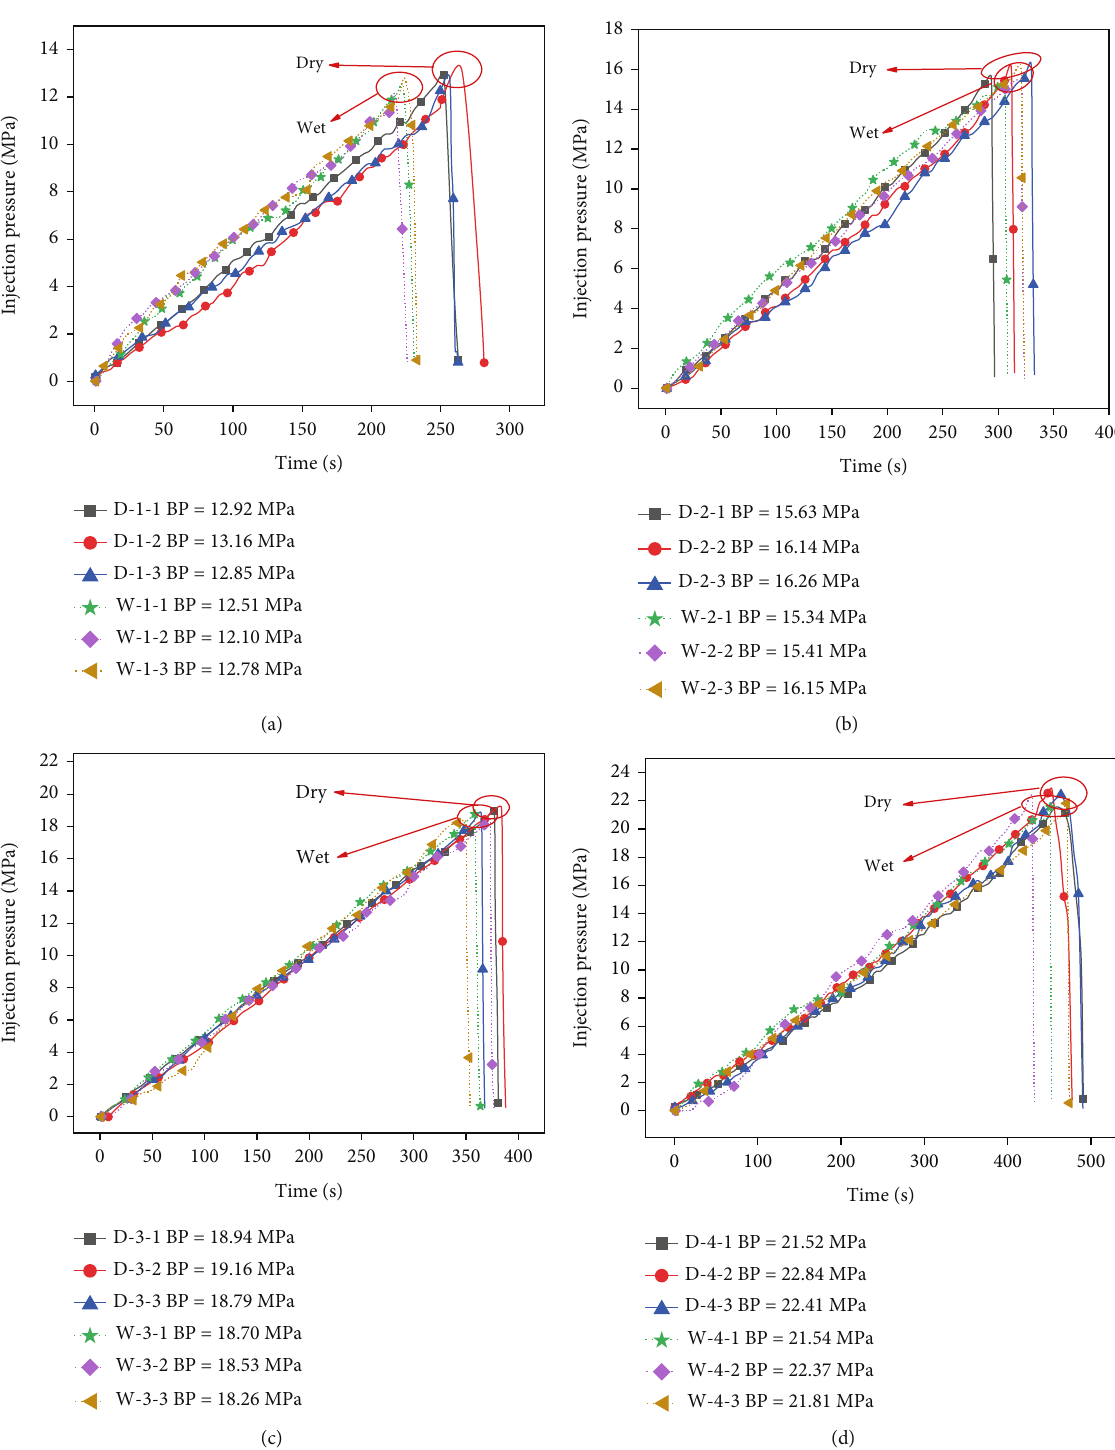
Figure 6: The nitrogen fracturing curves of dry and saturated parallel bedding shales without LN (a) con fi ning pressure = 3MPa ; (b) con fi ning pressure = 6MPa ; (c) con fi ning pressure = 9MPa ; (d) con fi ning pressure = 12MPa